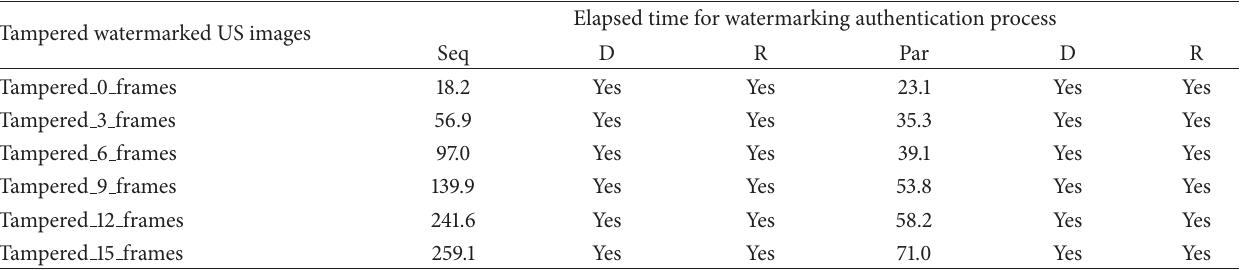
Figure 13: Ultrasound medical images tampered on frame numbers 2, 4, and 6. Table 9: A table of comparison on elapsed time of watermarking authentication process on different sets of tampered frames in watermarked ultrasound medical